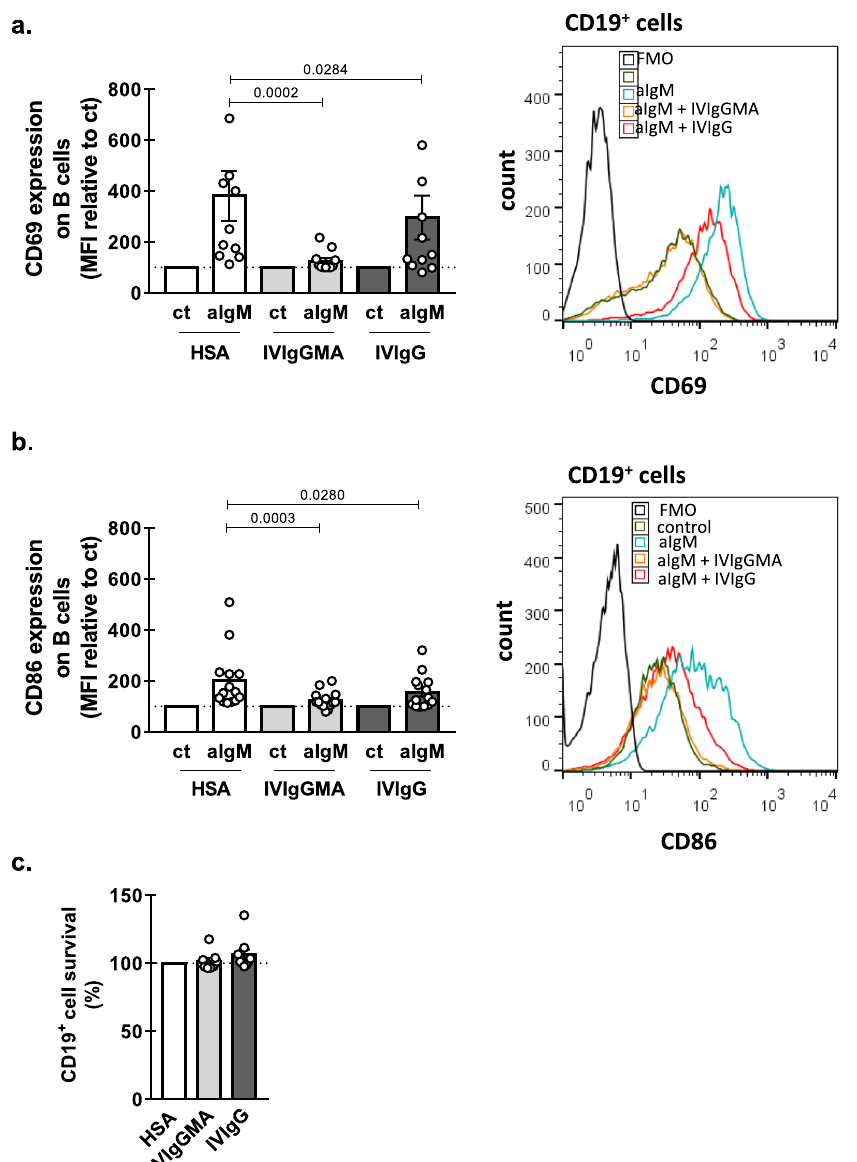
Figure 3. Effect of IVIg preparations on B cell activation. PBMC from CLL patients were cultured, in the presence of IVIgGMA, IVIgG (10 mg/mL of IgG) or HSA, in wells containing immobilized anti-IgM mAbs (25 µg/mL) or the corresponding isotype control, at 37 °C for 24 h as detailed in Materials and Methods. Then CD69 and CD86 expression was analyzed by flow cytometry. ( a, b ) The figures show the expression of the B cells activation markers CD69 ( a ) and CD86 ( b ) on leukemic B cells. Results are shown as the mean fluorescence intensity (MFI) of the activated condition relative to each control condition. n = 10 for CD69 and n = 14 for CD86. Individual values and the mean ± SEM are shown. Representative histograms are shown. ( c ) CD19 + cells survival was assessed by flow cytometric alterations of light scattering properties and confirmed by Annexin V staining. n = 9. Individual values are shown. Statistical analysis was performed using Friedman test followed by Dunn’s post-test on ( a , b ), and Wilcoxon test on ( c ). Significant p values are shown in the graph. p < 0.05 was considered